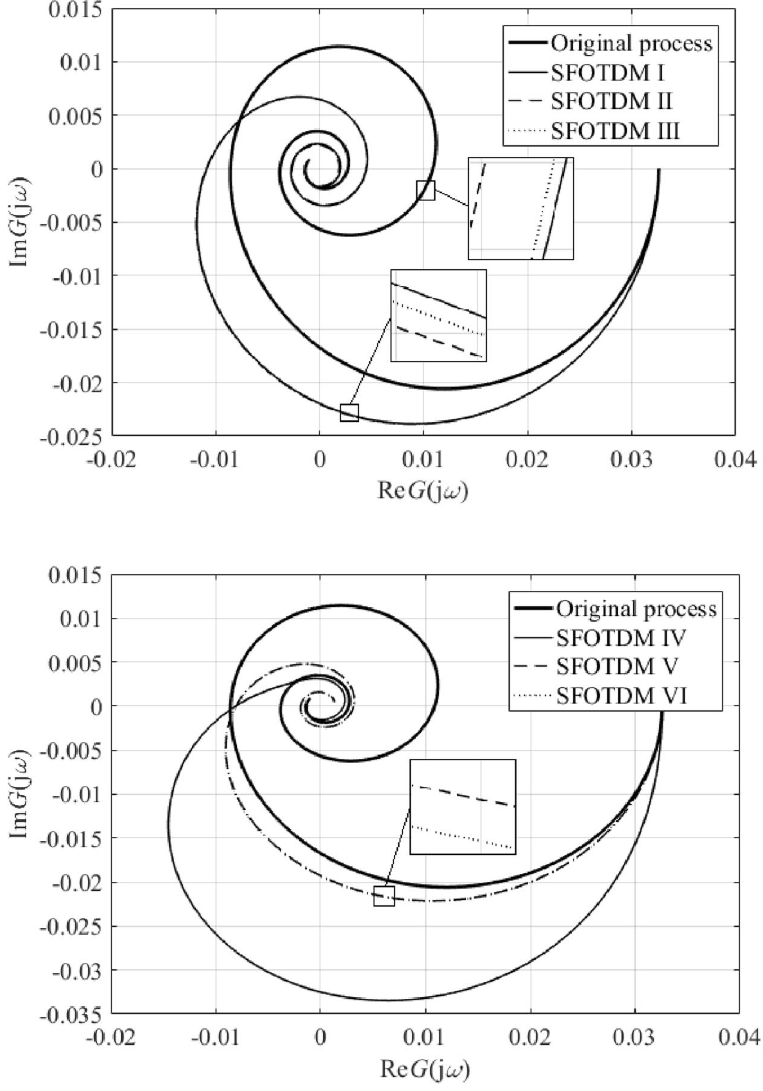
Figure 11. Comparison of SFOTDM Nyquist plots (vs. the original process characteristics).